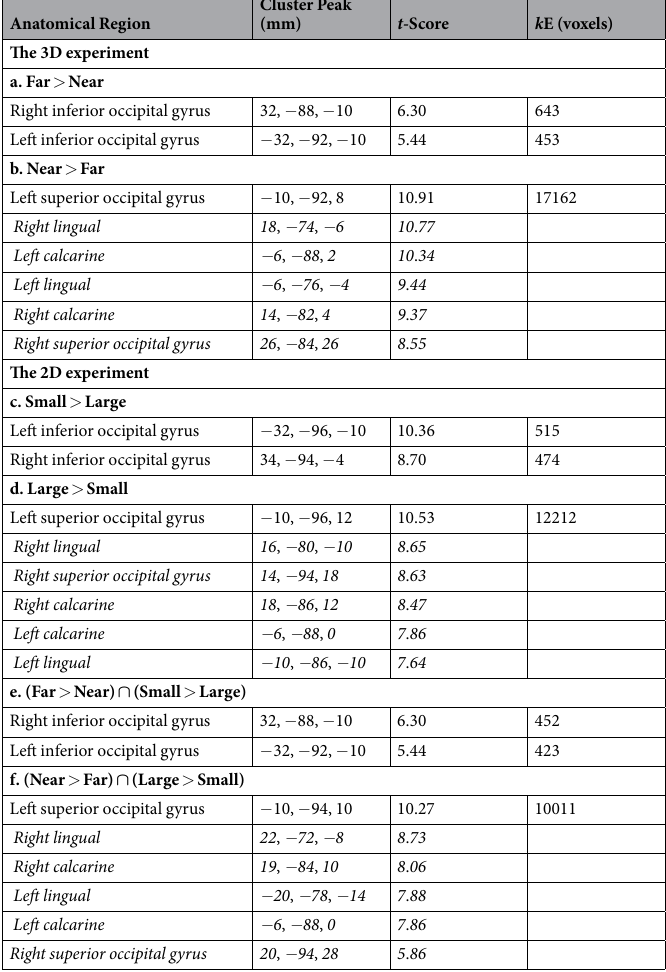
Large)” conjunction contrast (Fig. 1c upper panel and Table 1e). On the other hand, bilateral SOG, extending to bilateral calcarine and bilateral lingual gyrus, was significantly activated in the reverse conjunction contrast, i.e., “(Near > Far) ∩ (Large > Small)” (Fig. 1c lower panel and Table 1f). Psychophysiological interaction (PPI) analysis with bilateral inferior occipital gyrus as the source regions. In the 2D control condition, bilateral IOG showed higher neural coupling with the right superior parietal lobule in the “Small” condition than in the “Large” condition (Fig. 2 and Table 2a). In the virtual 3D condition, with the “Far > Near” contrast as the psychological factor, PPI analysis based on the neural activity of identical seed areas showed a different pattern from the 2D condition. The left IOG showed higher neural coupling with the right inferior frontal gyrus, the right superior frontal gyrus and the right infe- rior temporal gyrus in the far than near condition. The right IOG showed higher neural coupling with the right inferior frontal gyrus, the right superior frontal gyrus and the right inferior temporal gyrus in the far than near condition (Fig. 3 and Table 2b), which failed to pass the multiple comparisons correction at the cluster level (voxel threshold at p < 0.05, cluster size more than 800 voxels). We also used the SOG (derived from the conjunction analysis between “3D_Near > 3_Far” and “2D_ Large > 2D_Small”, Fig. 1c, lower panel) as the seeds to perform the PPI analysis. No significant PPI was found between SOG and other brain areas in either the 2D or the 3D condition.